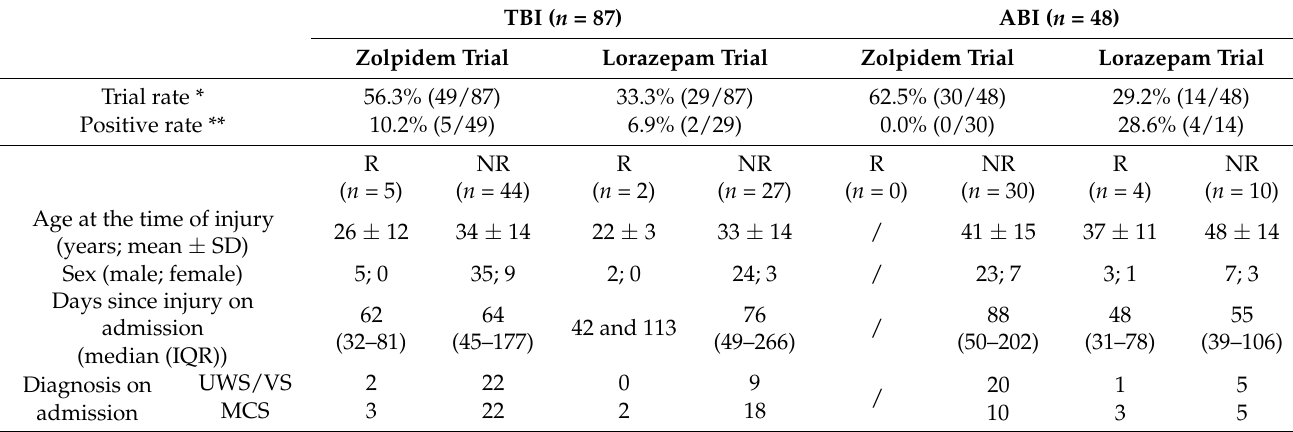
Table 2. The responders vs. the non-responders to the zolpidem and the lorazepam